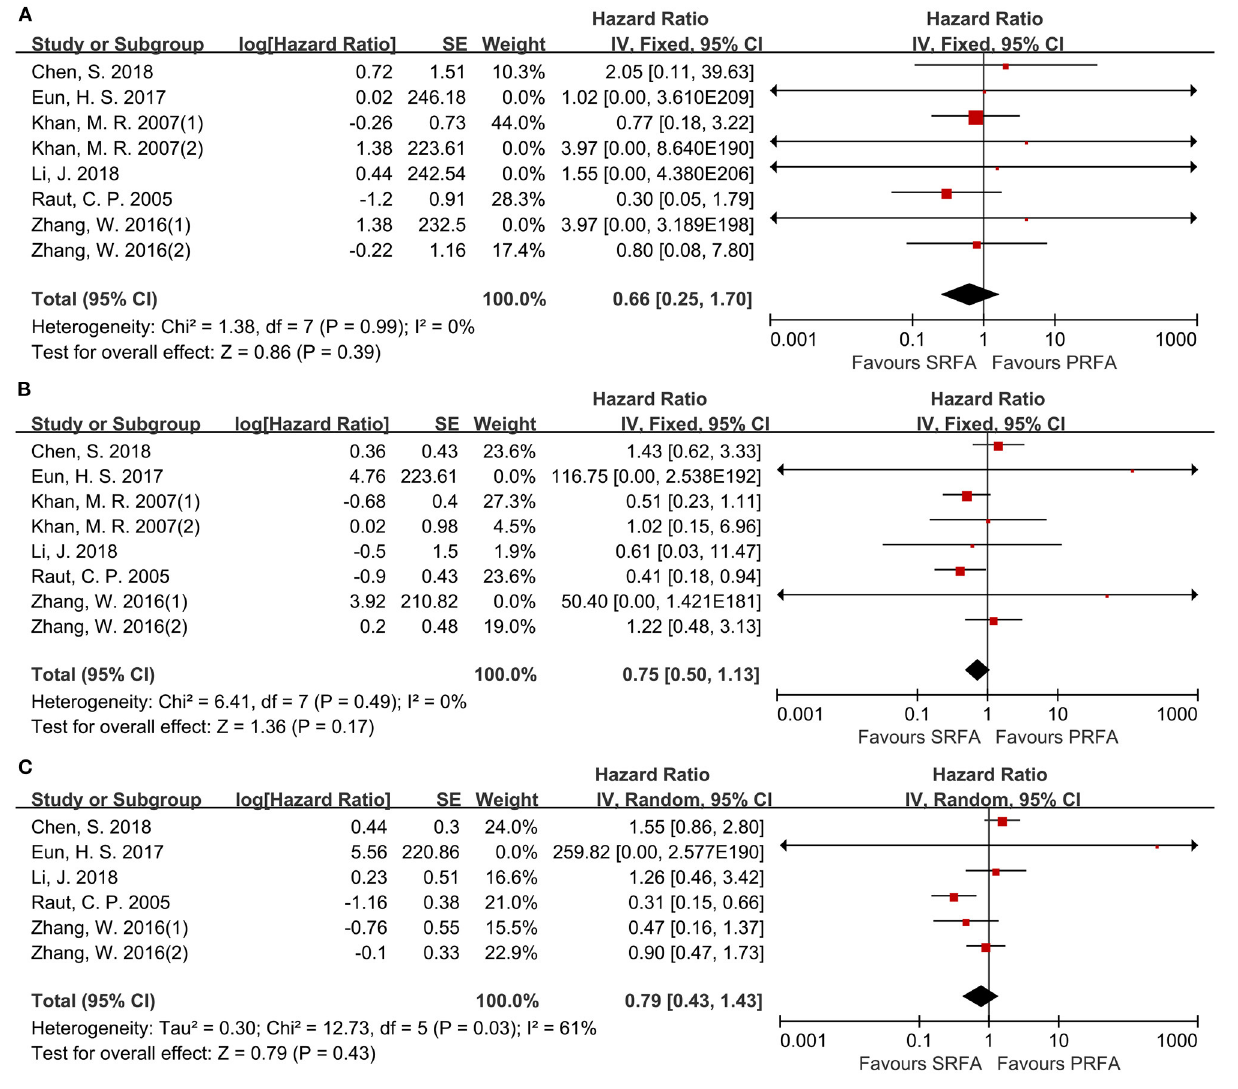
FIGURE 6 | Forest plot for OS. (A) Forest plot for 1-year OS indicates no significantly between the PRFA group and the SRFA group (HR, 0.66; 95% CI: 0.25–1.70). (B) Forest plot for 3-year OS indicates no significantly between the PRFA group and the SRFA group (HR, 0.75; 95% CI: 0.50–1.13). (C) Forest plot for 5-year OS indicates no significantly between the PRFA group and the SRFA group (HR, 0.79; 95% CI: